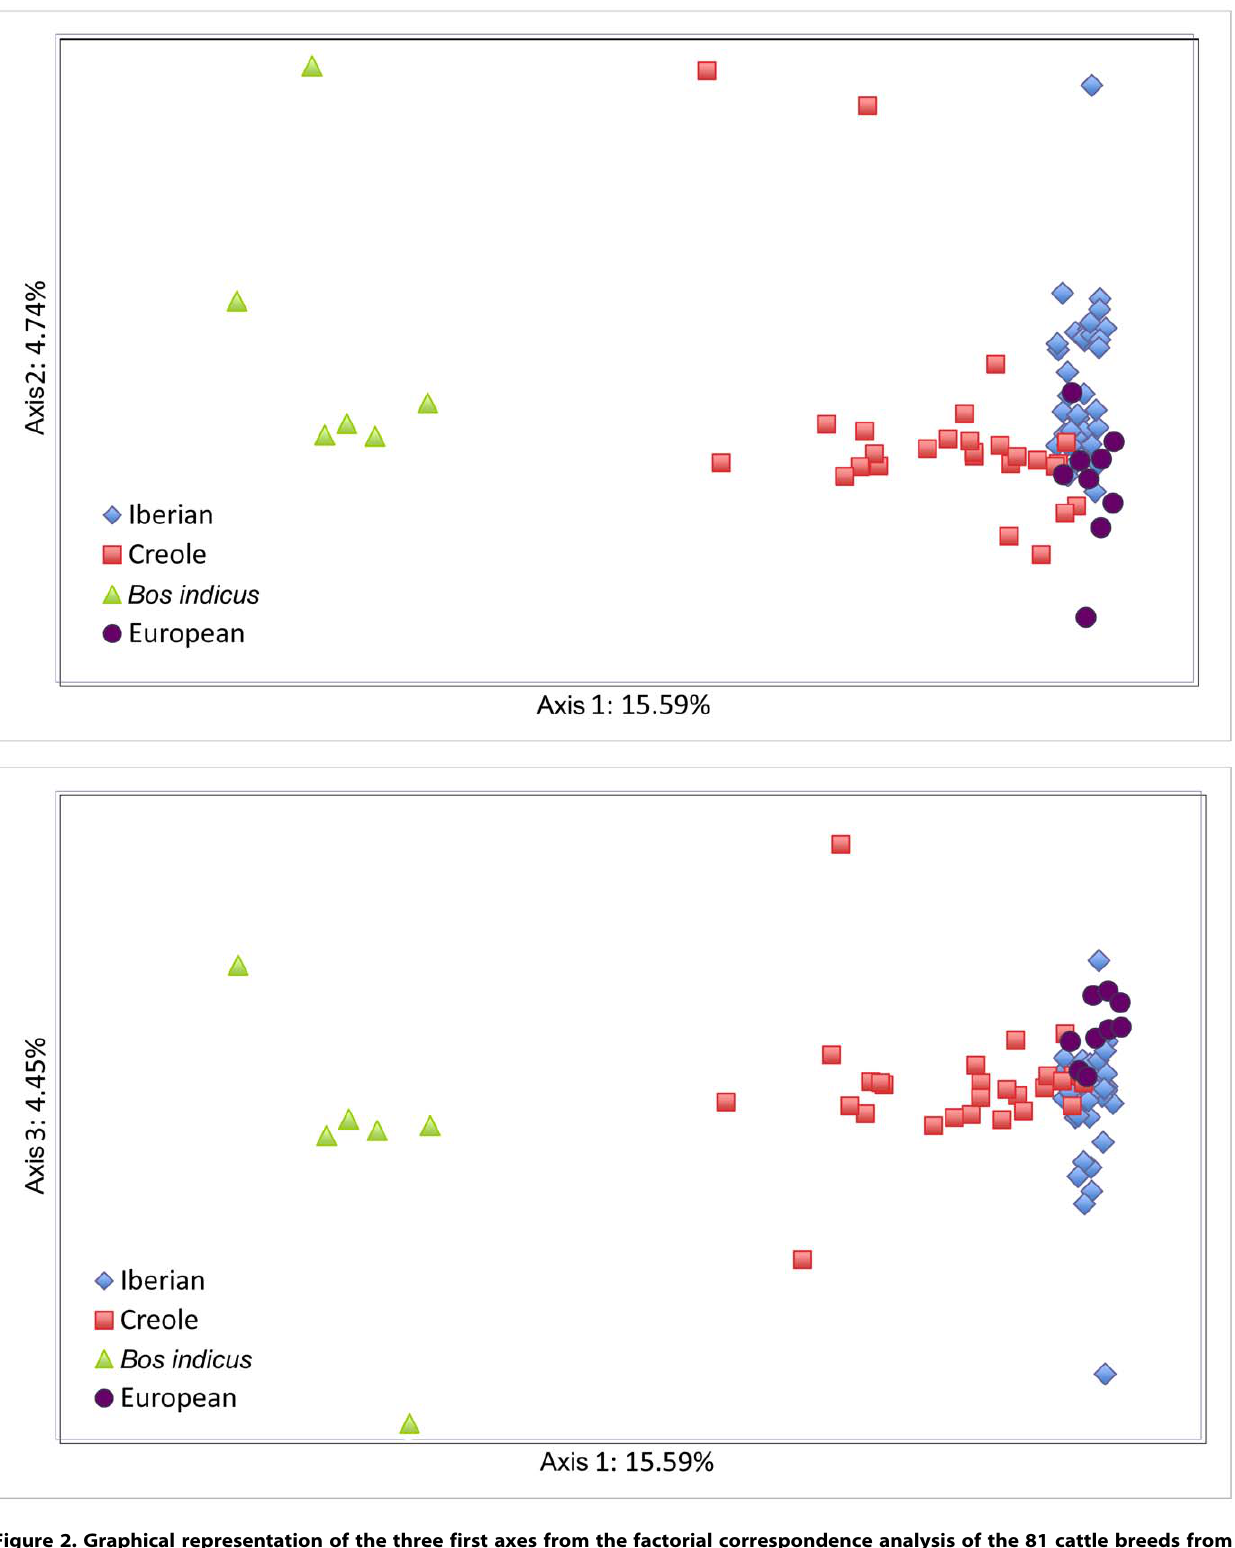
PLOS ONE | www.plosone.org